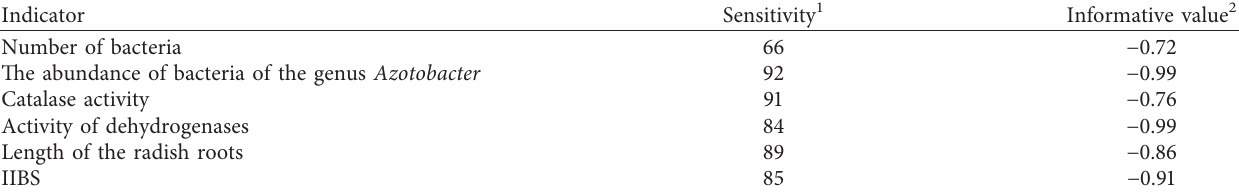
Table 2: Assessment of biological indicators of soil condition during silver contamination in terms of sensitivity and informative value. Indicator